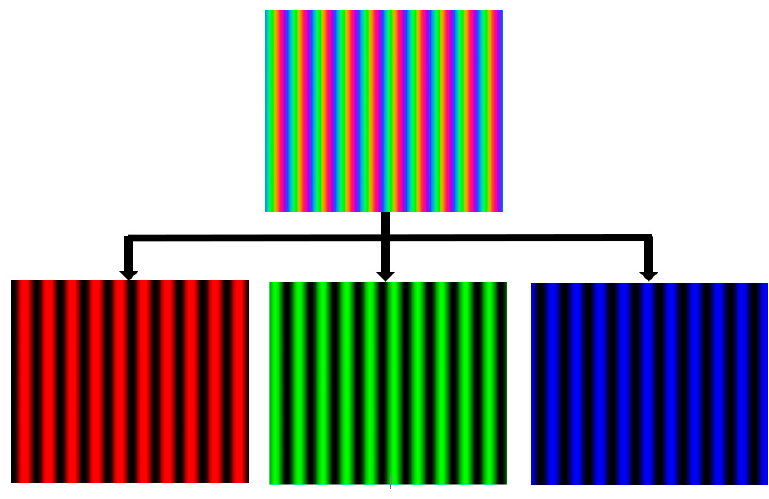
Figure 5. One color composite fringe pattern containing three fringe patterns.